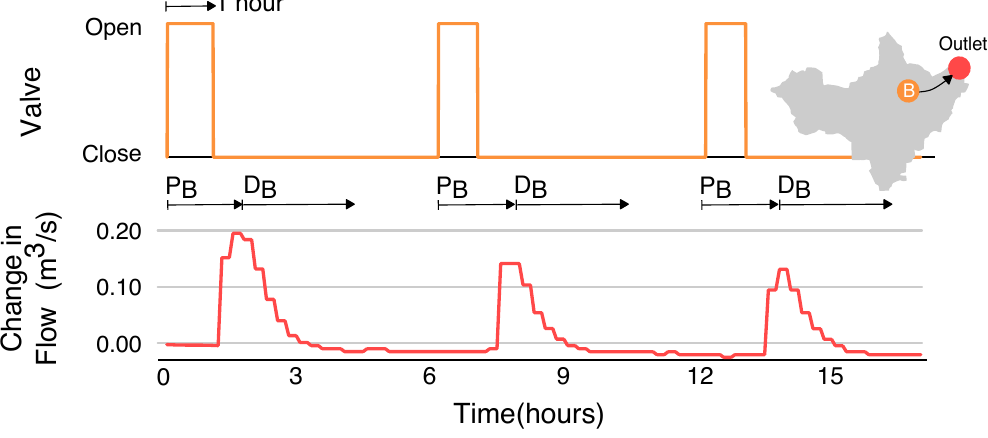
Figure 4. Characterization of control actions originating from site B. Three subsequent pulses are released. While the duration of each control pulse is the same (1 h), the magnitude of the flow at the outlet decreases because the hydraulic head (pressure) in the basin is reduced with each